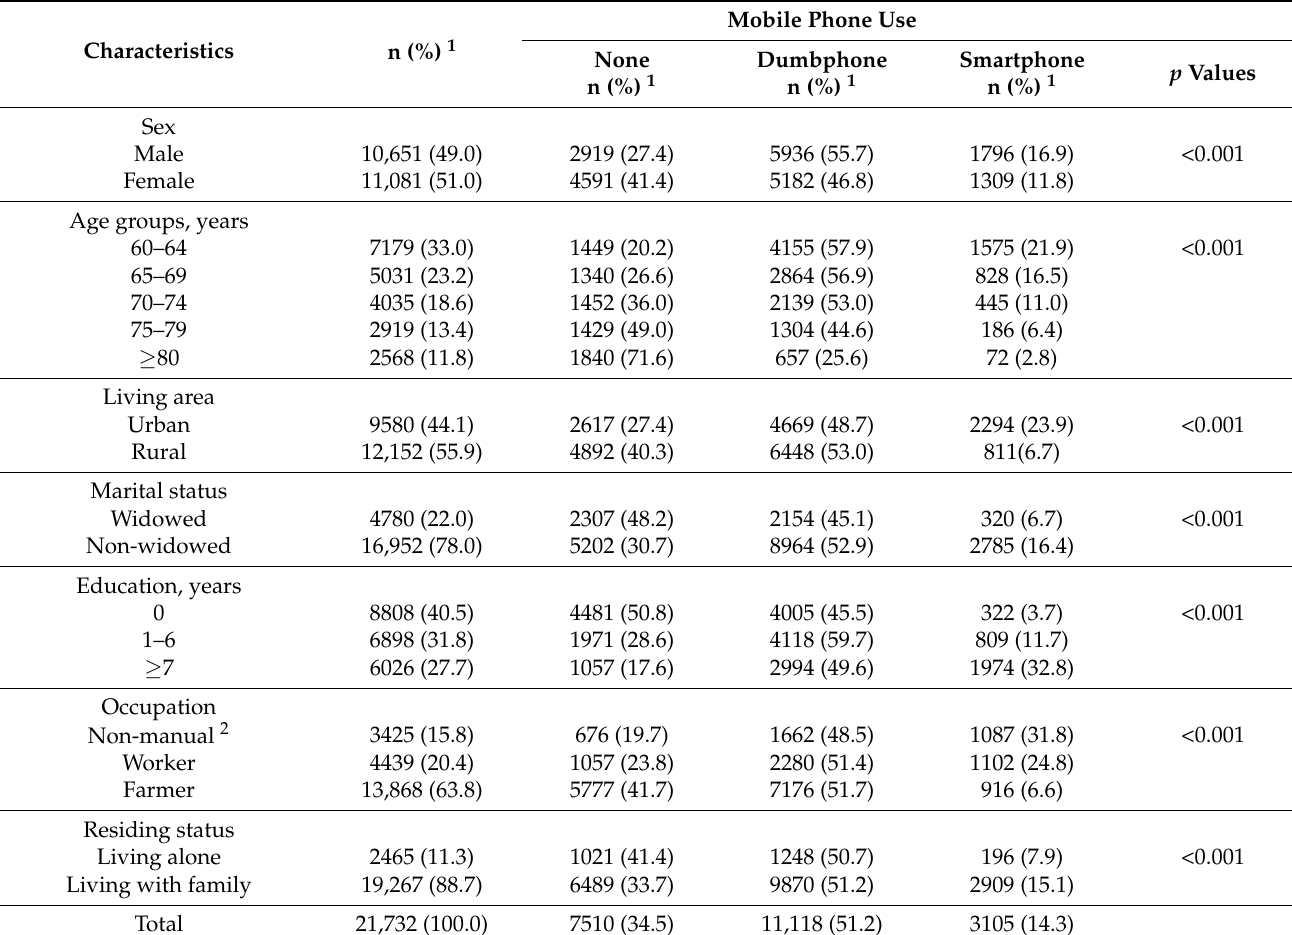
Table 1. Mobile phone use in different